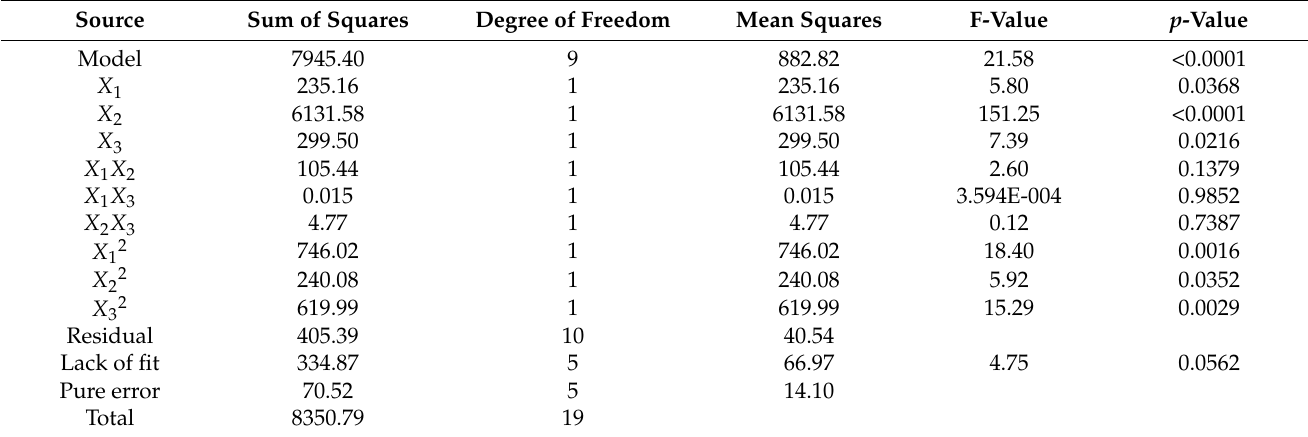
Table 5. ANOVA for response surface quadratic model on ED.